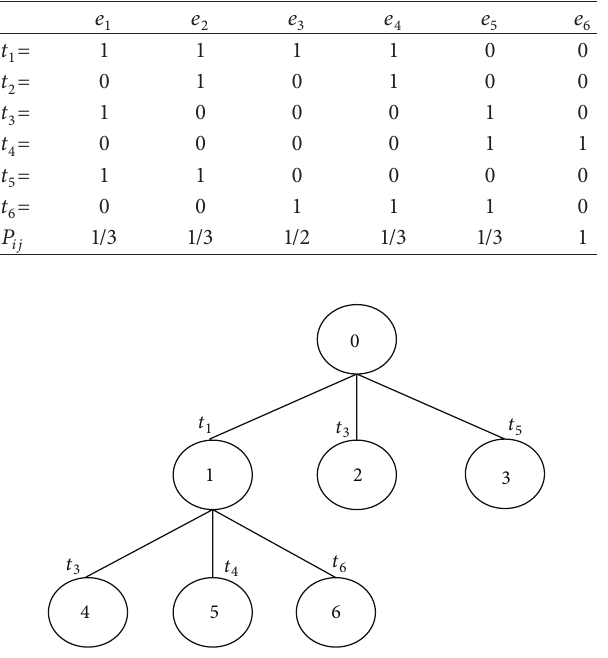
Figure 7: State space search tree generated by the proposed